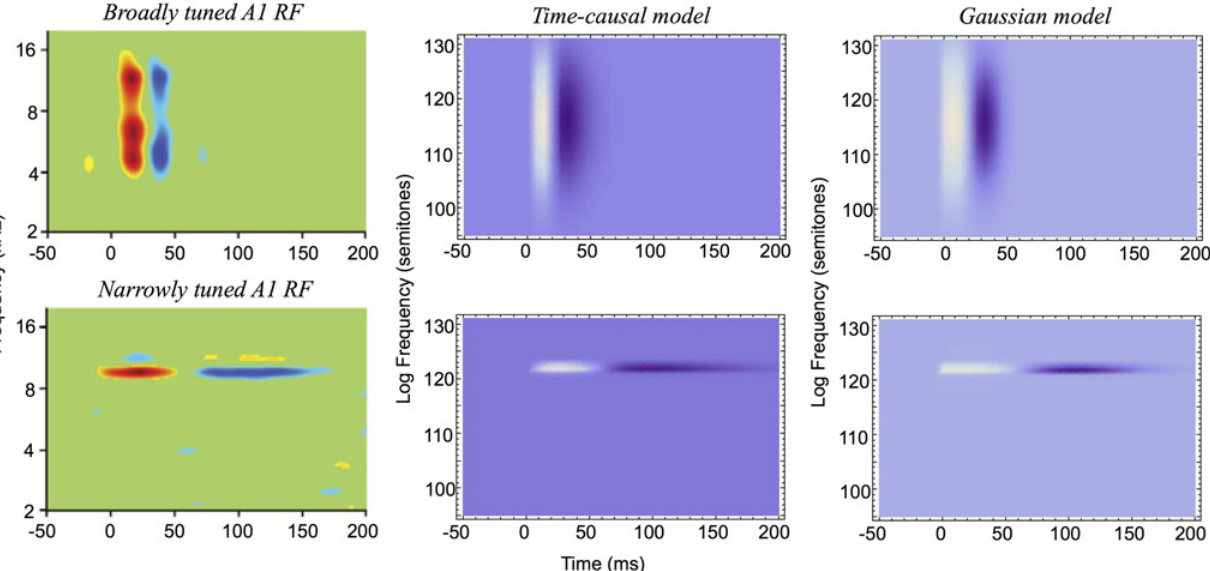
Fig 20. (left column) Spectro-temporal receptive fields of broadly and narrowly tuned neurons in the primary auditory cortex (A1) of cats as reported by Atencio and Schreiner [40]. In terms of the idealized models of receptive fields, such broad or narrowly tuned receptive fields correspond to different values of the logspectral scale parameter s . (middle and right columns) Idealized receptive fields models (90) corresponding to first-order derivatives with respect to time, in the left column centered at semitone ν = 119, temporal scale σ t = 12 ms, logspectral scale σ ν = 8 semitones for both models and additionally temporal delay δ = 20 ms for the Gaussian model and in the bottom column centered at semitone ν = 122, temporal scale σ t = 45 ms, logspectral scale σ ν = 0.5 semitones for both models and additionally temporal delay δ = 60 ms for the Gaussian model.